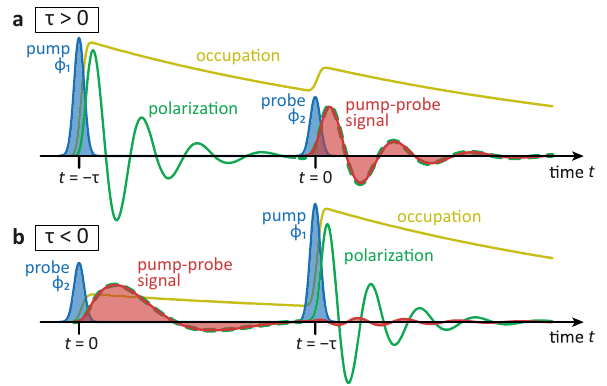
Figure 3: Schematic picture of the pump-probe signal generation. (a) For positive delays and (b) for negative delays. The signal (red) is launched by the probe pulse at t = 0 and carries contributions from the occupation (yellow) and the polarization (green) after the pump pulse for 𝜏 > 0 (a). For 𝜏 < 0, the signal changes its dynamicsby the latter impinging pump pulse (b).